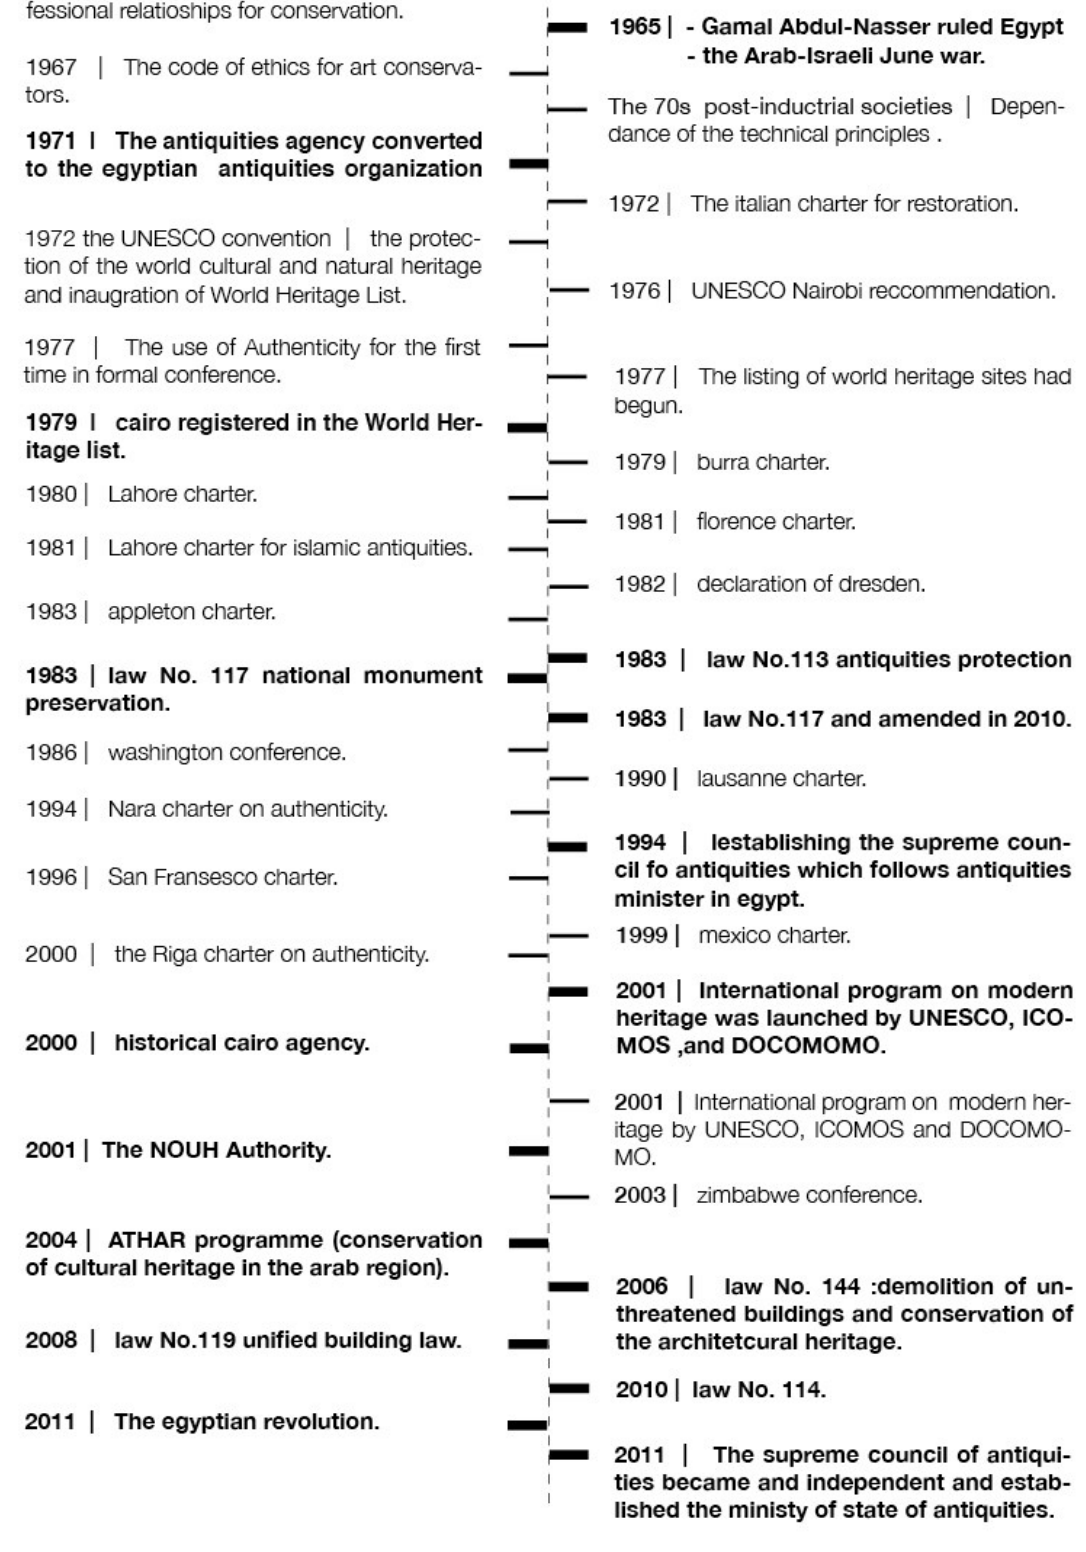
Figure 1. A timeline of the evolution of conservation in the international track and the Egyptian one in bold (Developed by the